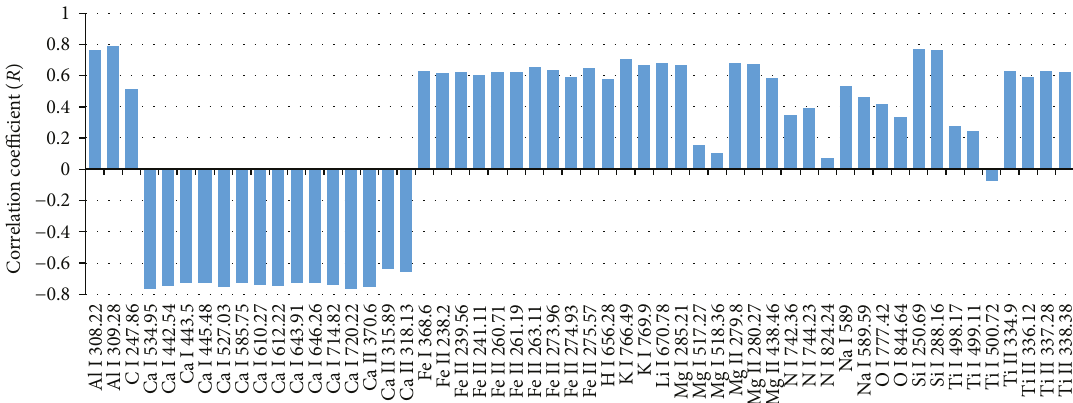
Figure 9: Correlation of spectral line intensity with concentration of sulphur.